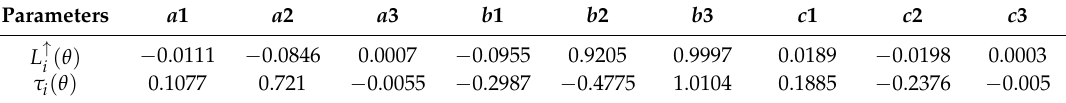
Table 2. Angular Dependent Atmospheric correction coefficients of Equation (12) for